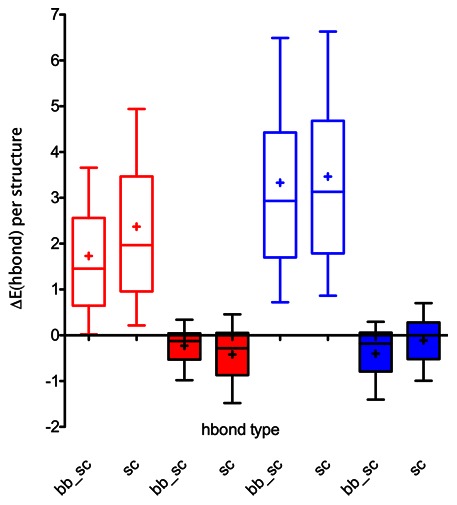
High-charge variant hydrogen bond energy changes per structure (600 total).In high-charge AvNAPSA designs (AvNAPSA cutoff of 150), removal of hydrogen bonds costs 1.5 to 3 Rosetta energy units per structure (empty bars). In contrast, Rosetta designs with the same net charge preserve hydrogen bonds (solid bars).